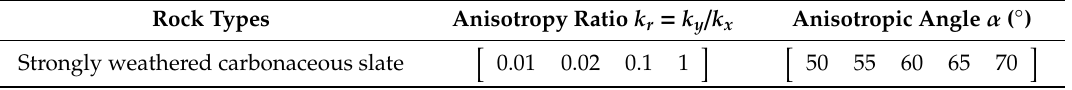
Table 3. Calculation